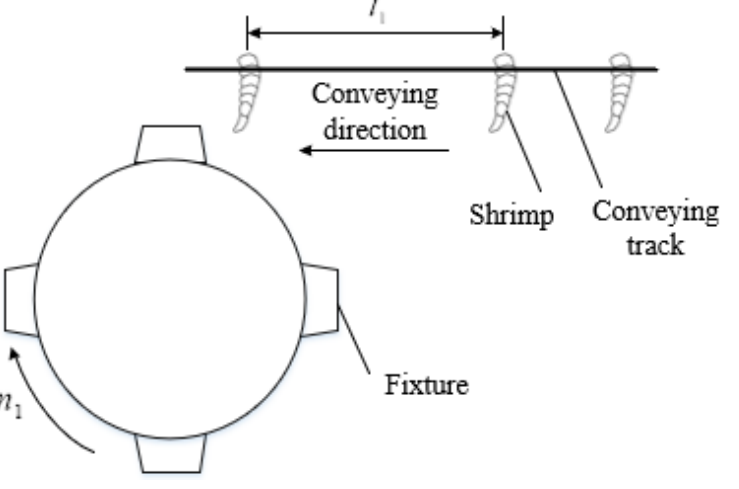
Figure 3. Cycle clamping fixture.